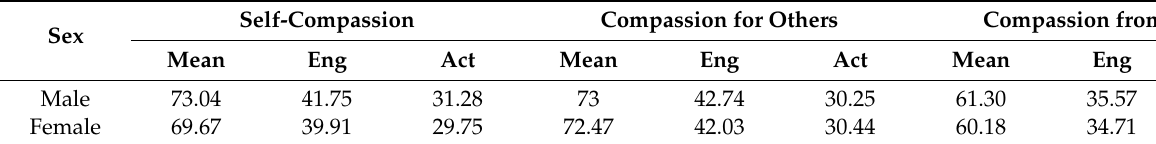
Table 4. Compassionate engagement and actions